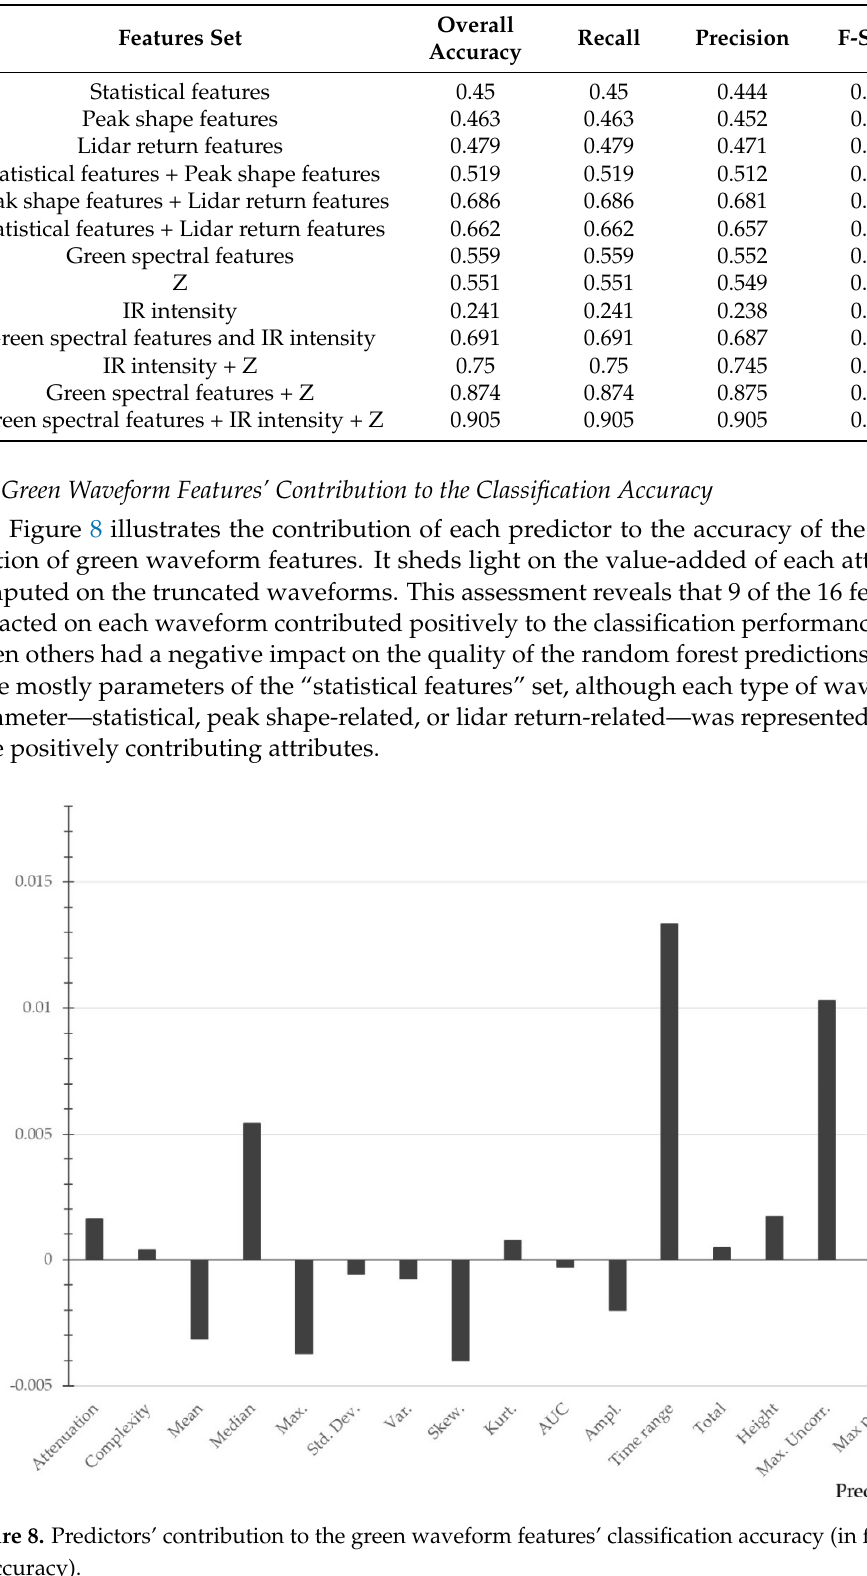
Table 3. Performance metrics obtained by each random forest experiment.